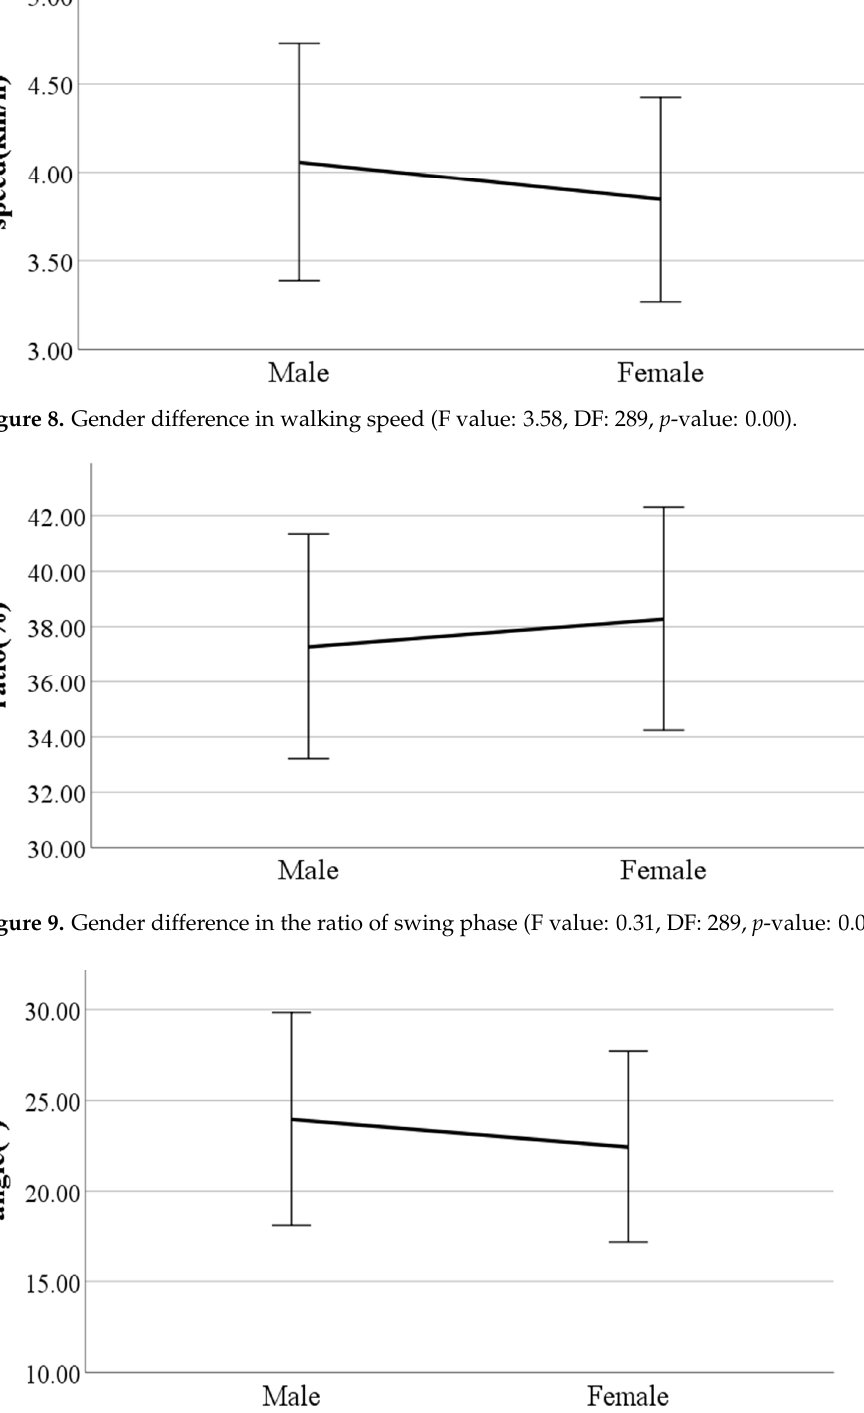
Figure 10. Gender difference in foot angle at heel-strike (F value: 0.82, DF: 289, p -value: 0.02).